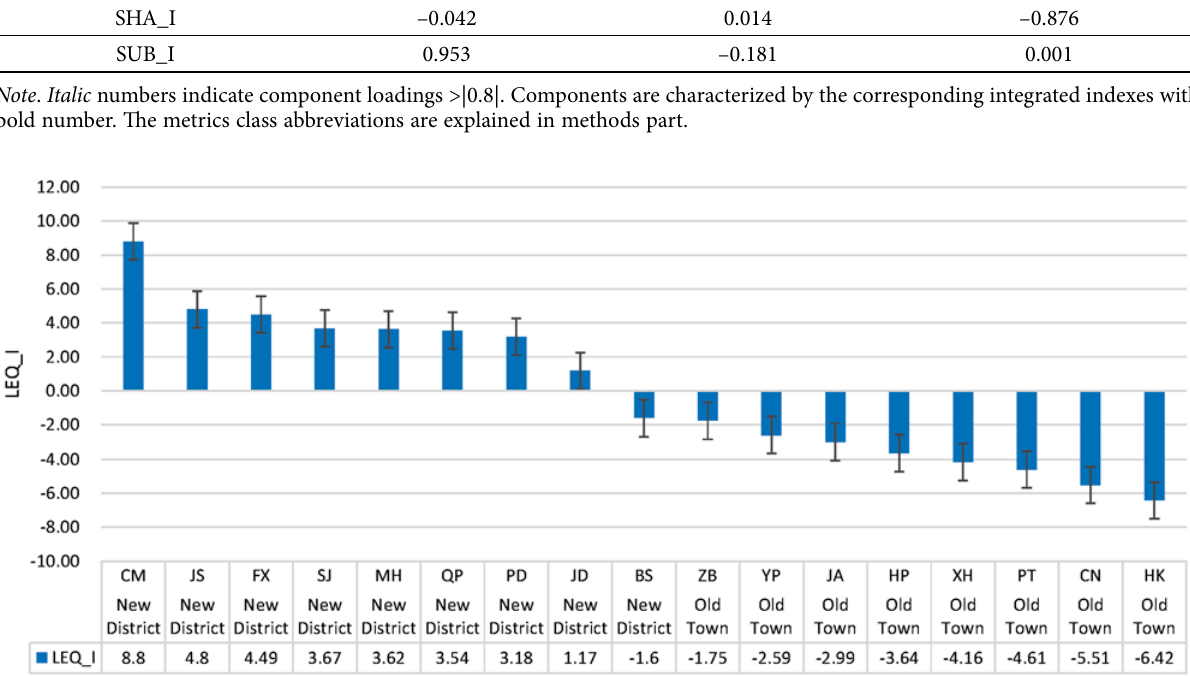
Fig. 5. Landscape ecological quality index values for districts in Shanghai